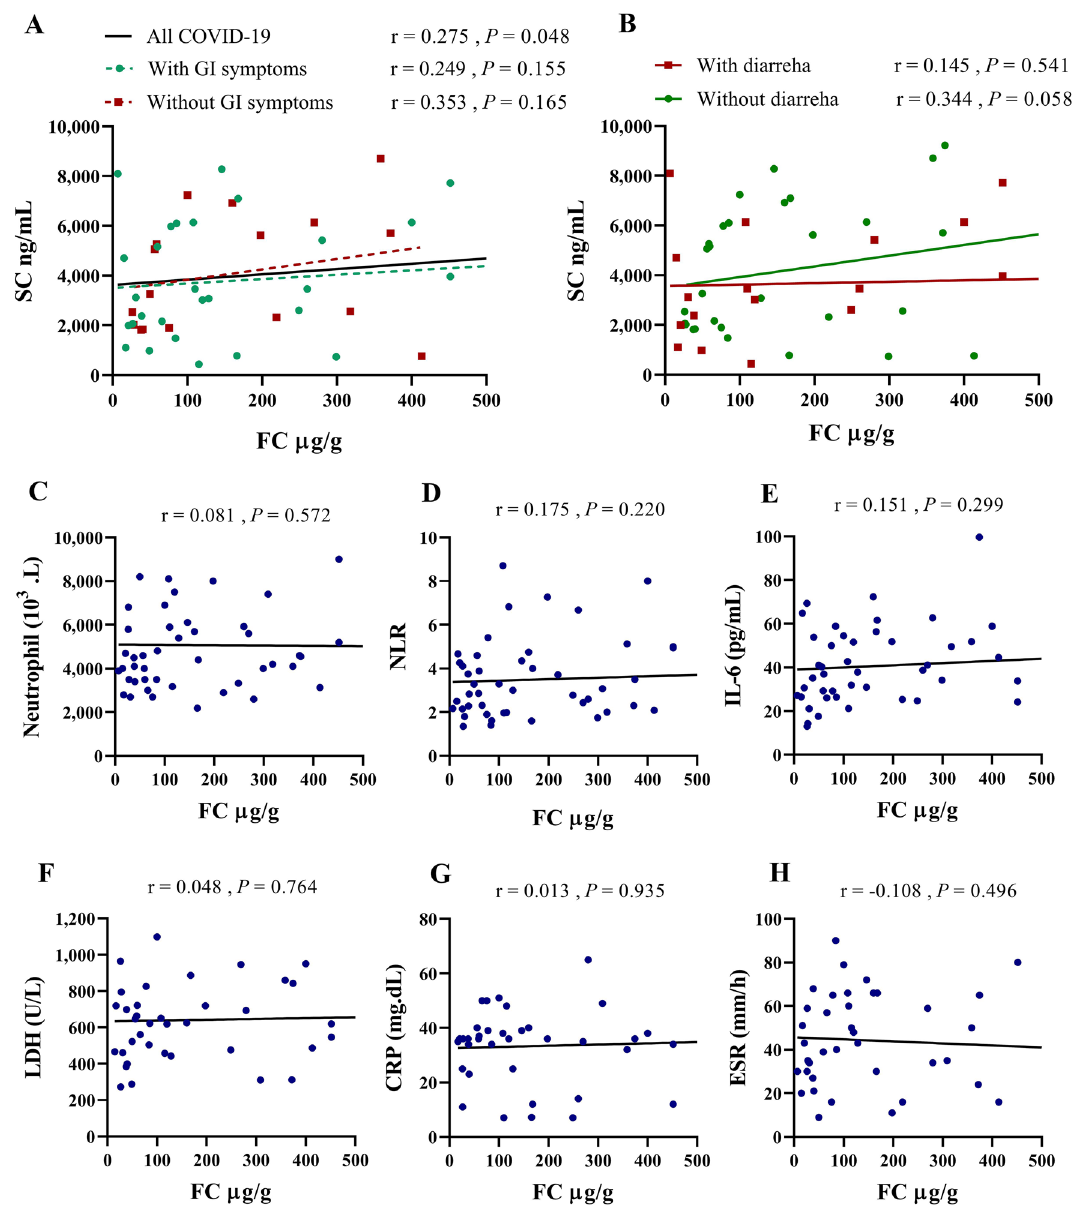
Figure 4. Correlation of FC with clinical laboratory studies. Data were examined by Pearson correlation and Spearman correlation for normal and non-normal data. Correlation coefficients and P values are shown in the